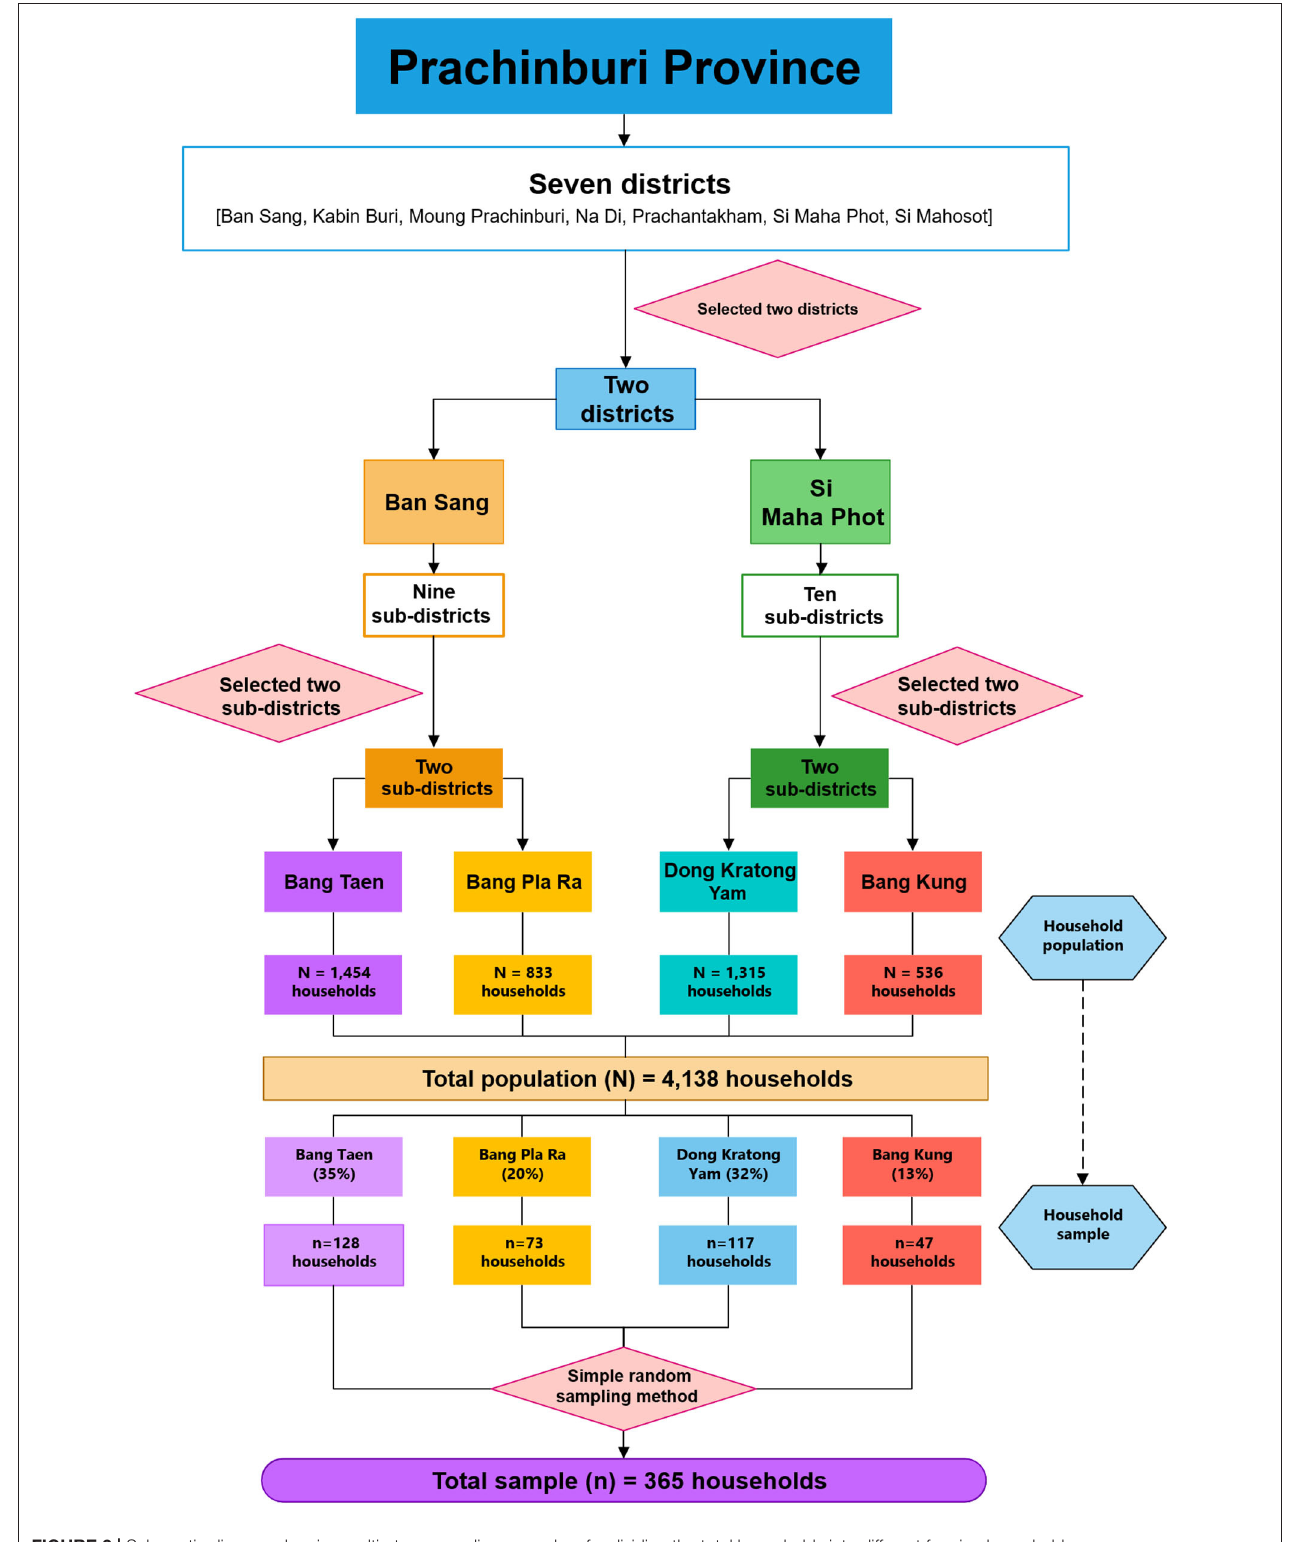
FIGURE 2 | Schematic diagram showing multi-stage sampling procedure for dividing the total households into different farming household groups.